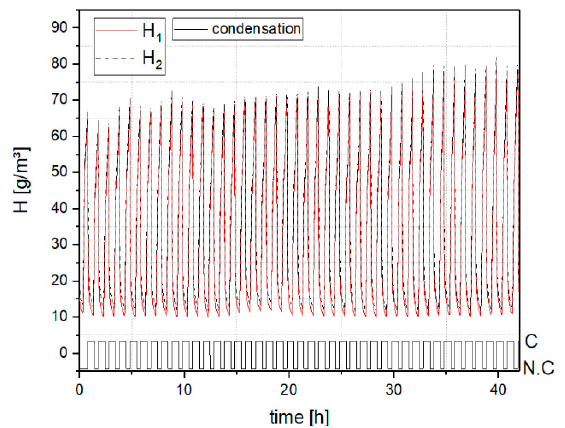
Figure 14. Absolute humidity of the air and condensation inside the housing during abnormal operation in case of the battery system equipped with PCE.